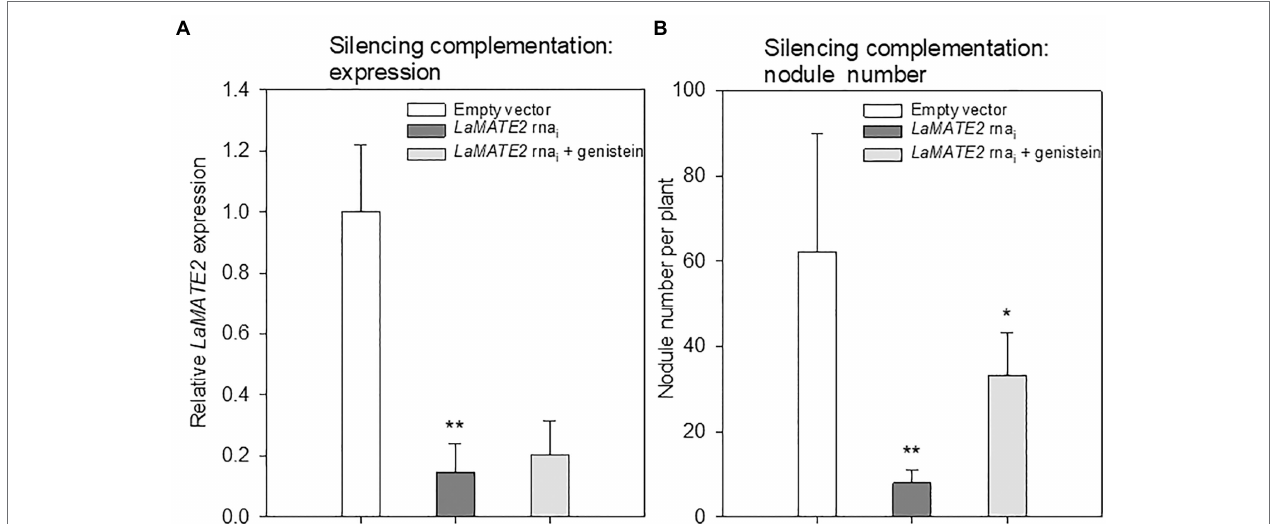
FIGURE 6 | Effect of exogenous genistein on LaMATE2 expression and nodule numbers. LaMATE2 relative expression (A) and number of nodules per plant (B) in roots of N-deficient lupin plants independently transformed with either pRedRoot:: LaMATE2 RNAi ( LaMATE2 RNAi) or empty-vector pRedRoot (Empty vector) or RNAi roots treated with 1 μ M genistein ( LaMATE2 RNAi + genistein). Expression data are shown relative to LaMATE2 expression level in empty vector-transformed roots. Data are mean + SD (Asterisks refers to statistically significant differences among the mean value of RNAi vs EV or RNAi+G vs RNAi values, ANOVA Holm–